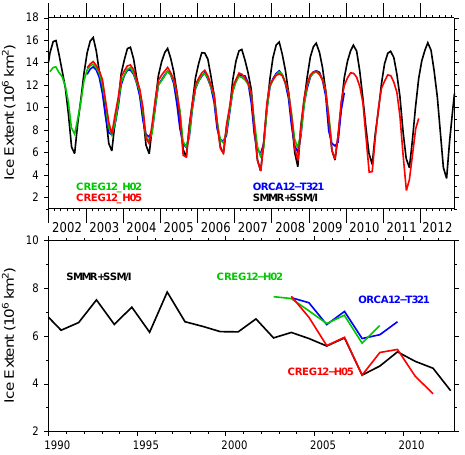
Figure 13. Ice concentration for September 2007 from NSIDC, the ORCA12 T321 run from Mercator Océan and CREG12 hindcasts H02 and